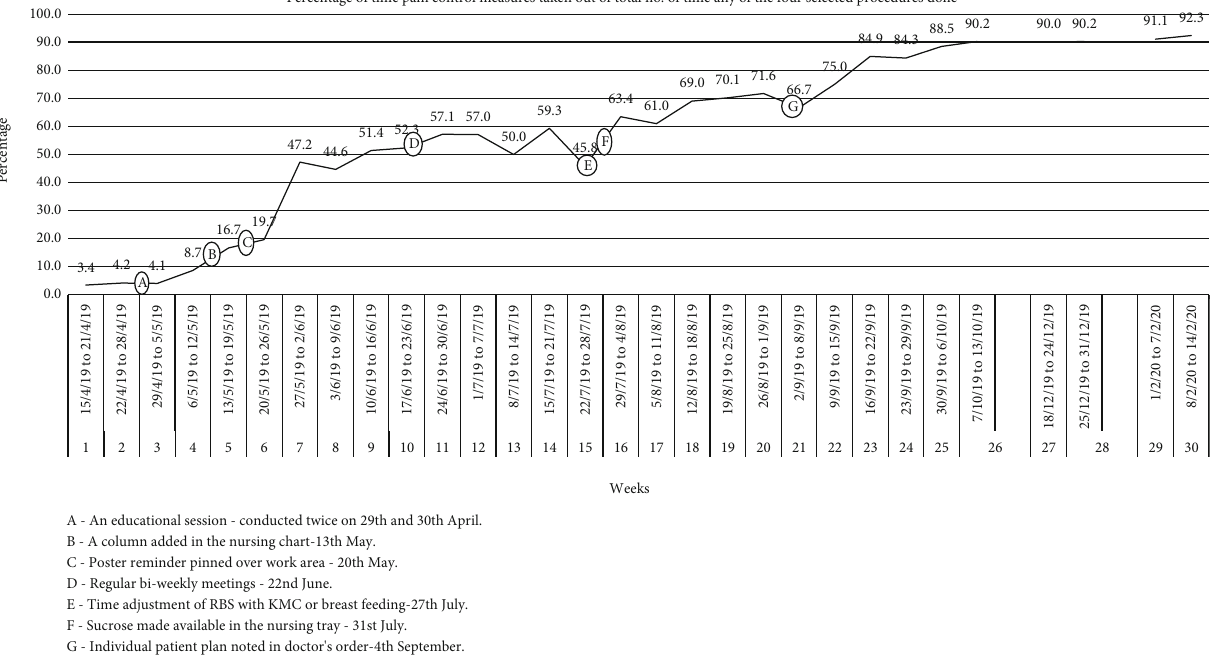
Figure 2: Percentage of time pain control measures taken out of total no. of time in any of the four selected procedures